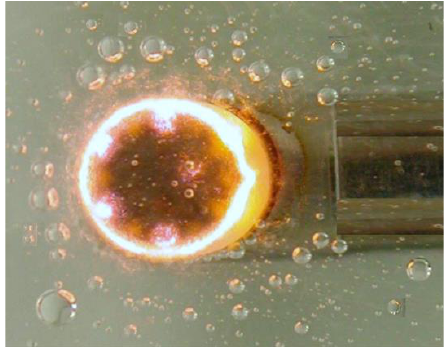
Figure 2. Plasma is generated in the water-vapor layer on the powered